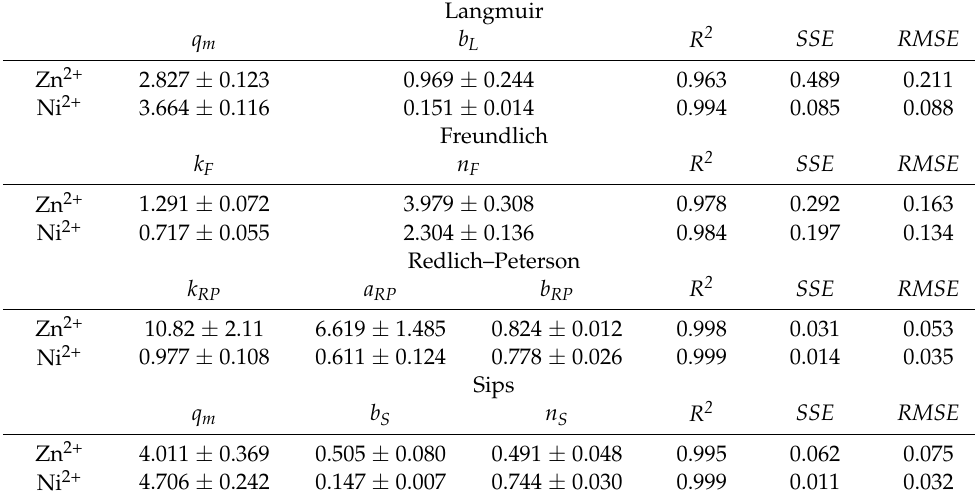
Table 3. Parameters of the mono-component isotherm models for Zn 2+ and Ni 2+ biosorption onto CS.